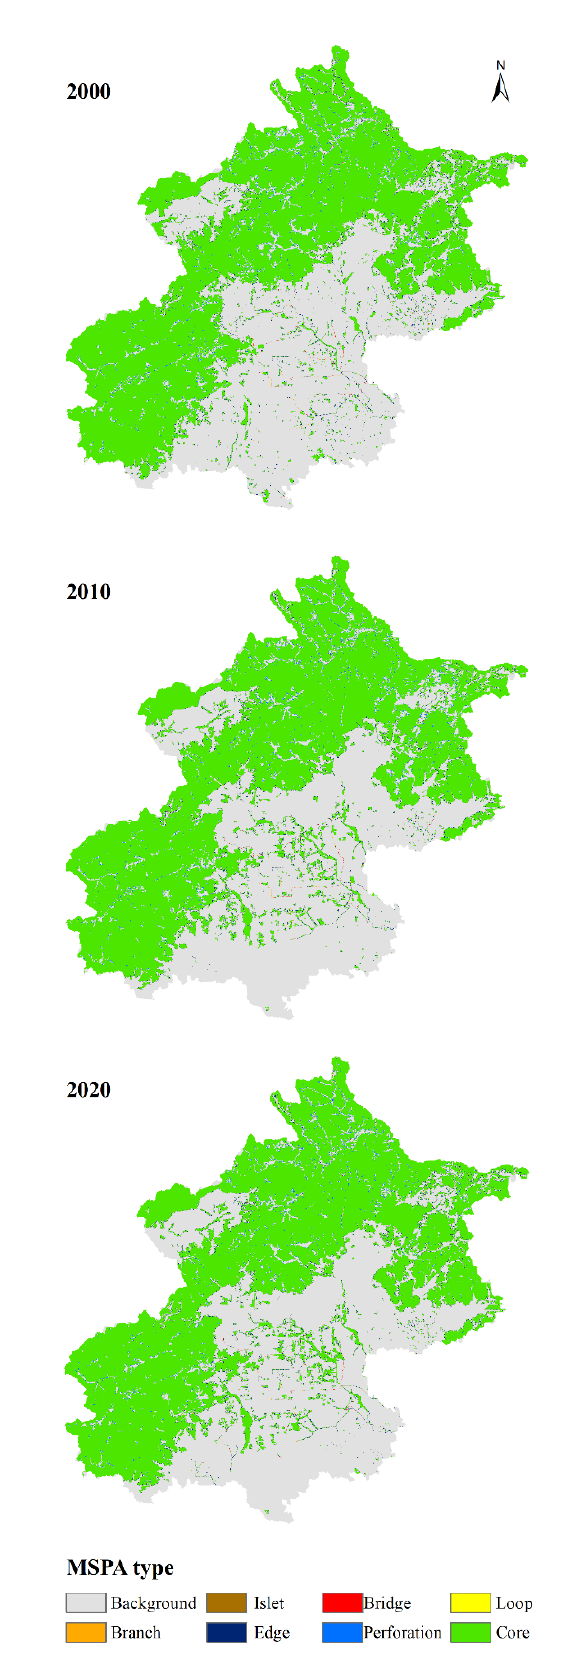
Figure 2 . MSPA types distribution maps from 1990 to 2015 in